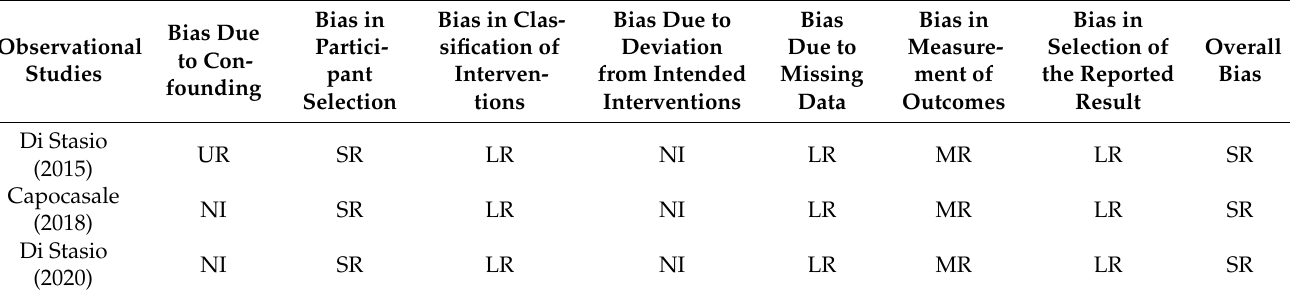
Table 2. ROBINS-I assessment for the three selected